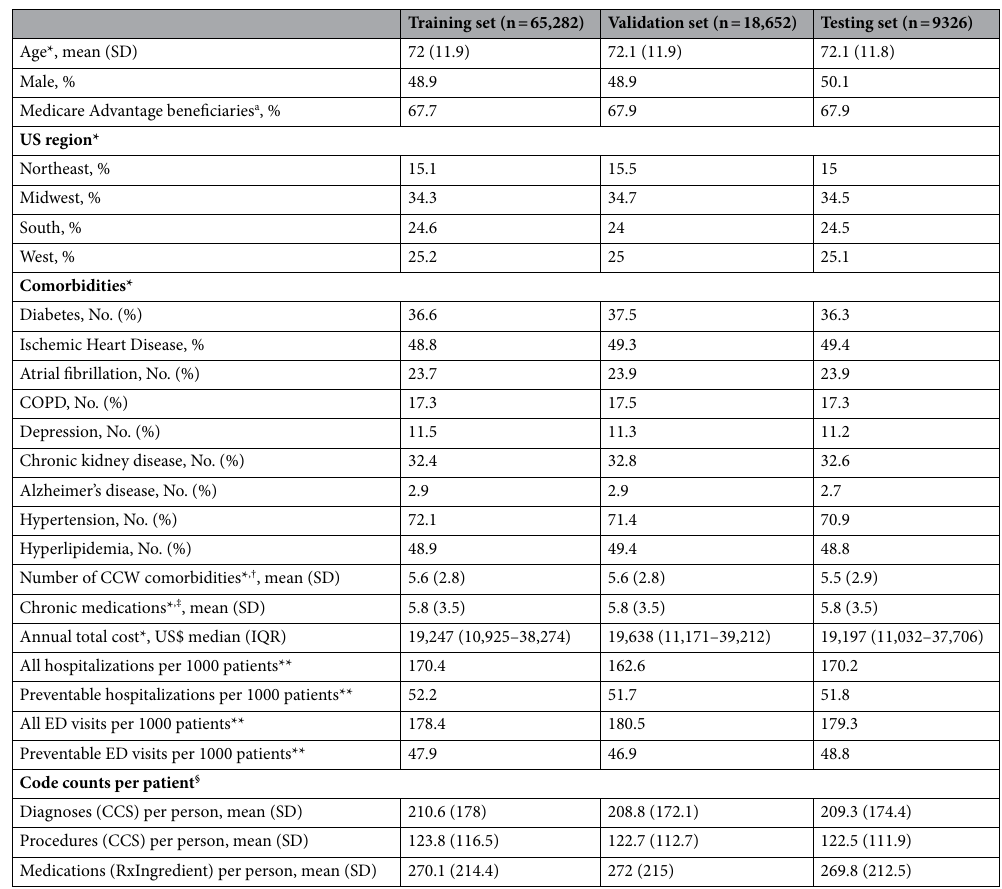
Table 2. Baseline characteristics of the training, validation, and testing datasets. *Results were calculated according to the observation period: 1/1/2016 – 12/31/2016. † Among the CCW comorbidities evaluated at Online Table 3. ‡ Defined as prescription drugs prescribed in the period of 7/1/2016–12/31/2016 as follows: at least one prescription of > 60 days, at least 2 prescriptions of 20 < days < 60. Oral, respiratory intravenous, intramuscular, and subcutaneous medications were included. § The number of codes is important when comparing deep learning algorithms. The number represents each patient’s sum of codes throughout all of his history in the data. ** Calculated within the prediction period (1/1/2017–1/7/2017). CCS, Clinical Classifications Software; CCW, Chronic Condition Warehouse (CCW); COPD, Chronic Obstructive Pulmonary Disease; ED, Emergency Department.